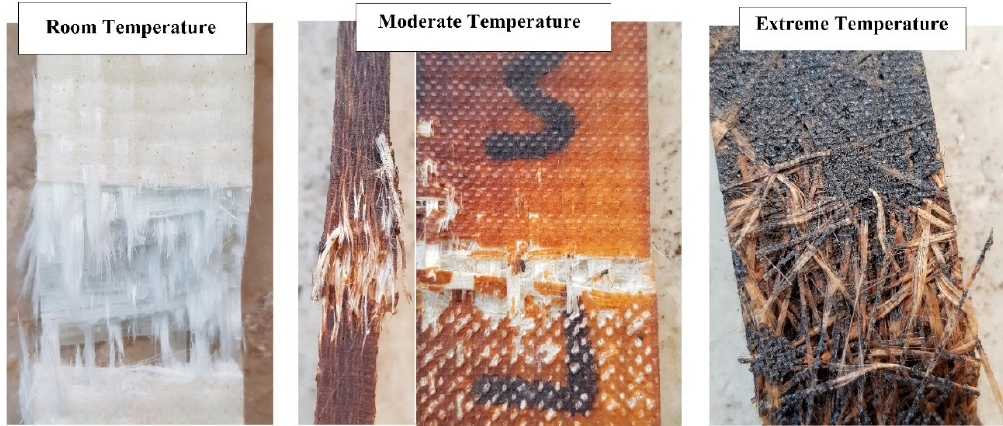
Figure 5. Typical failure modes of FRP laminates after exposure to elevated temperatures.